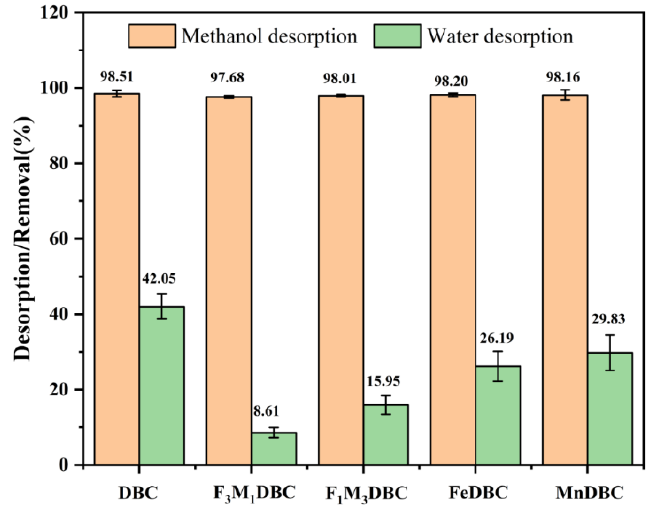
Figure 6. The desorption rates of atrazine from pre-atrazine-loaded biochar by DI water and meth-